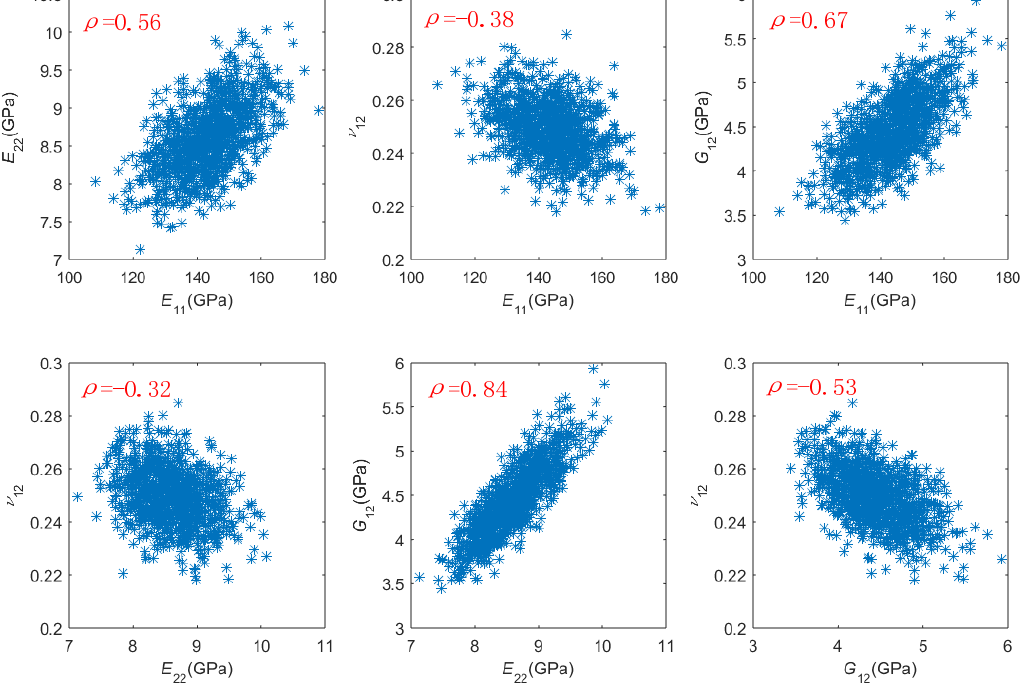
Figure 6. One thousand group of samples on E 11 , E 22 , ν 12 , and G 12.